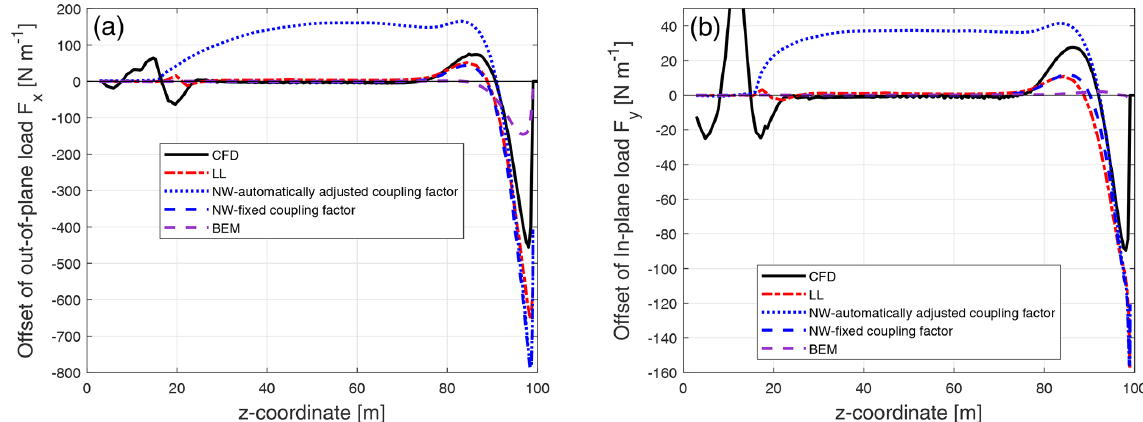
Figure C6. Comparison of the difference between the out-of-plane load (a) and the in-plane load (b) of the forward swept Blade-8 with respect to the baseline blade calculated from the Navier–Stokes solver (CFD), the lifting-line method (LL), the proposed coupled method (NW) and the blade element momentum method (BEM).